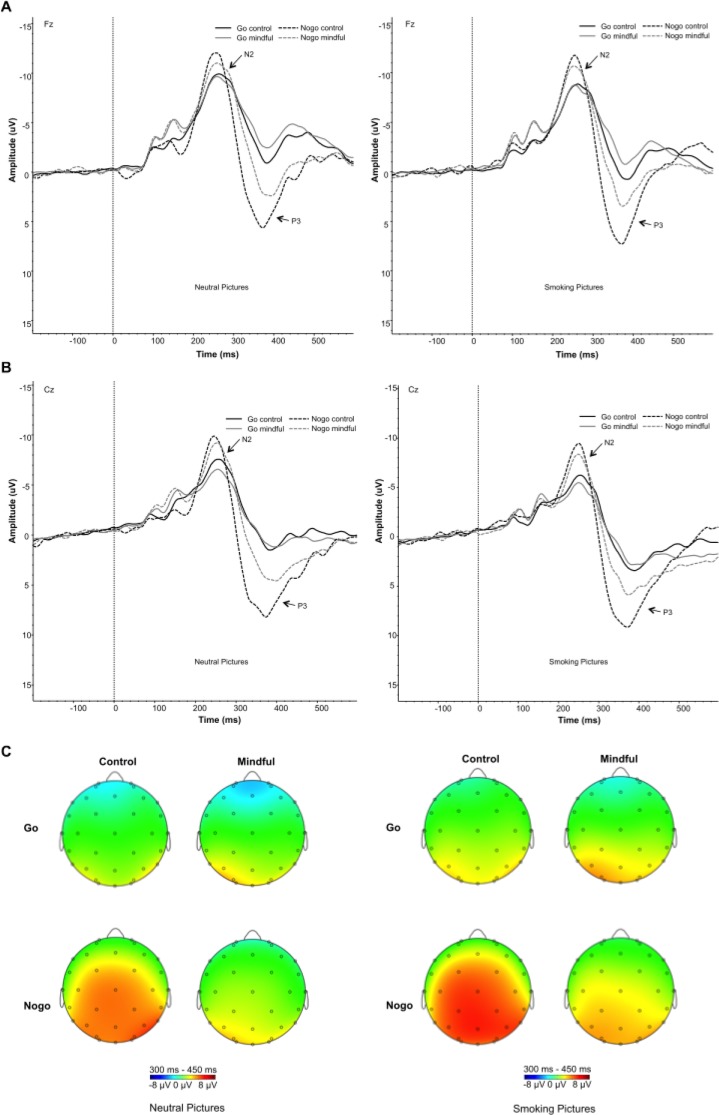
Effects of mindfulness on neural indices of response inhibition.Shown are grand-average stimulus-locked ERP waveforms for neutral (left) and smoking pictures (right) at Fz (Panel A) and Cz (Panel B), separately for correct Go and NoGo trials and the mindfulness and control group. Scalp voltage maps are shown in Panel C for mean amplitude for 300–450 ms. As can be seen, the mindfulness group displayed a reduced NoGo P3 compared to the control group.